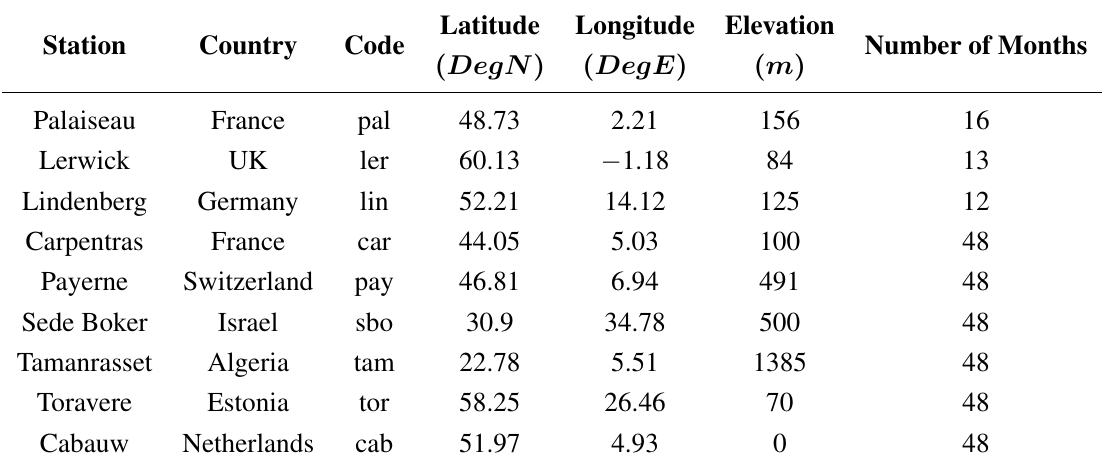
Table 2. List of Baseline Surface Radiation Network (BSRN) stations